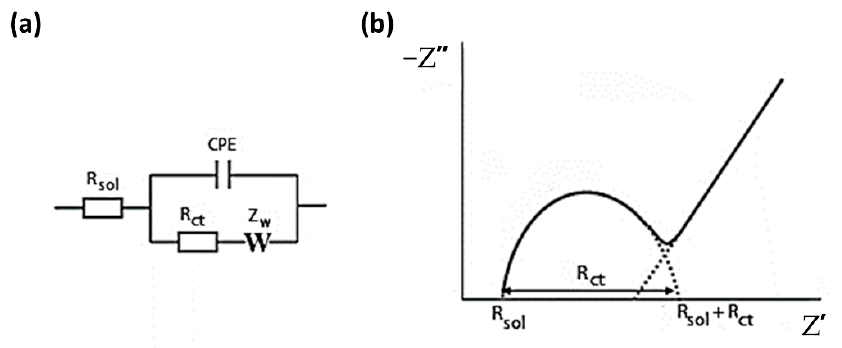
Figure 1. ( a ) Randles equivalent circuit and ( b ) the impedance response of the circuit depicted in the Nyquist